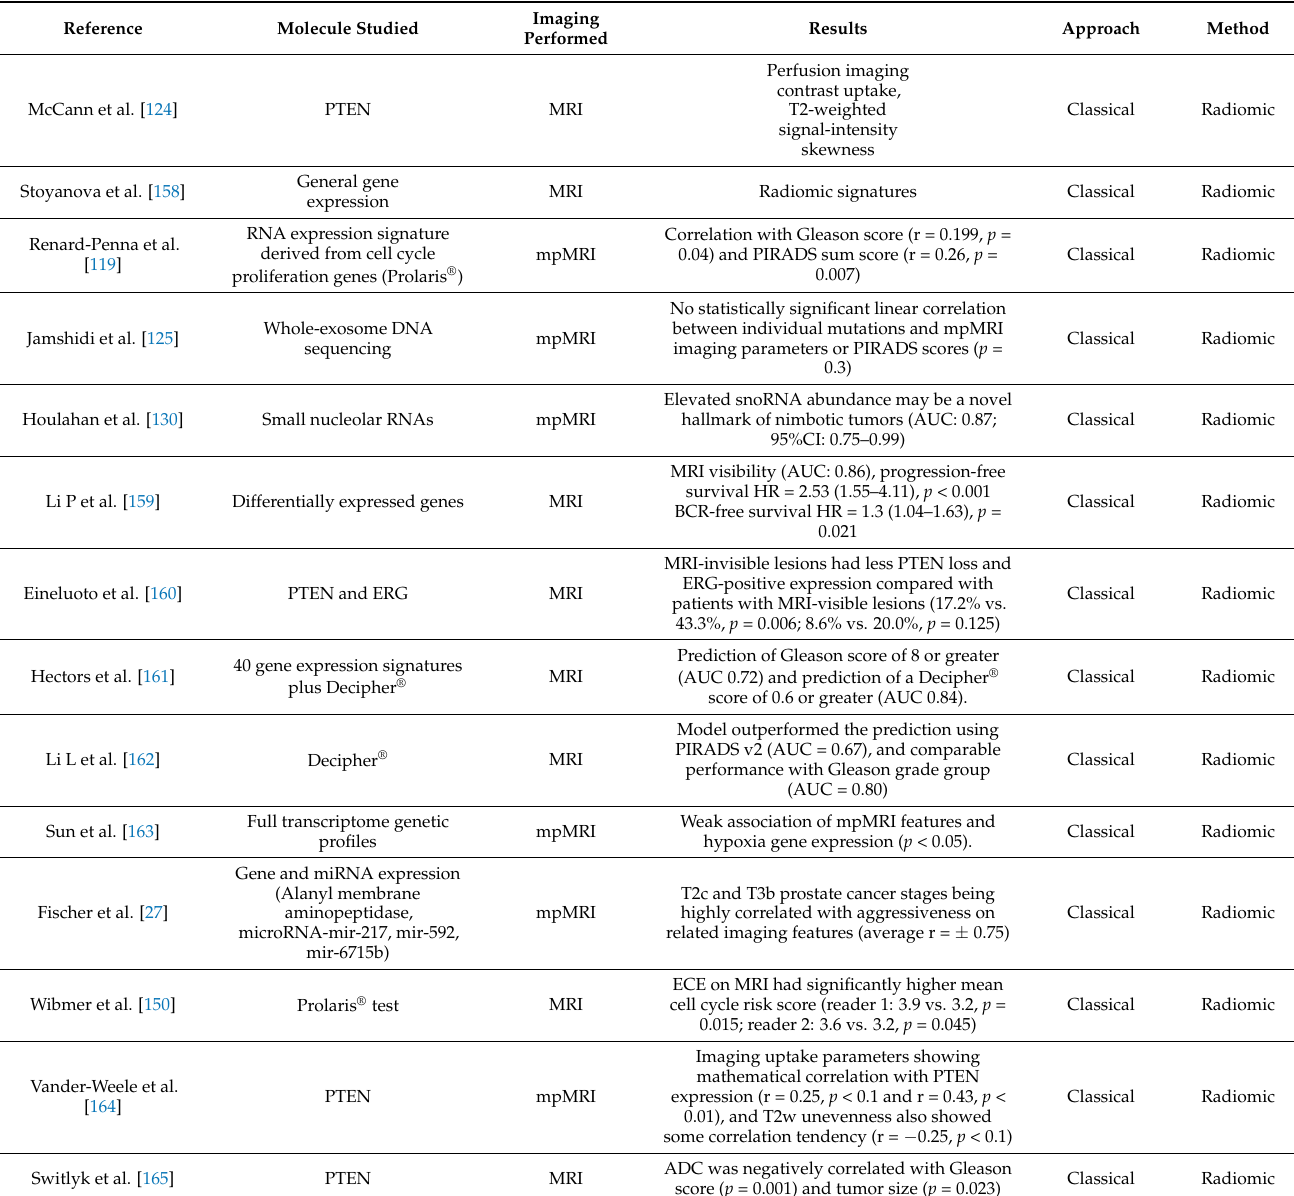
Table 4. Overview of radiogenomic literature on prostate cancer.